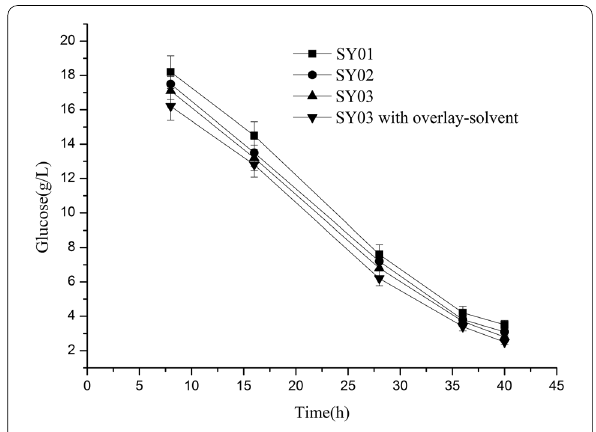
Fig. 3 The time course of glucose concentration of engineered E.